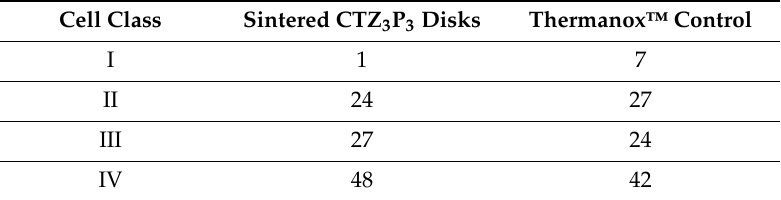
Table 5. Rating (%) of the cell vitality, proliferation and